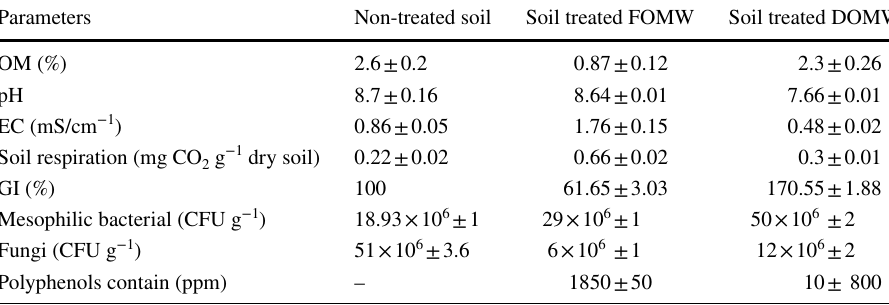
Non-treated soil was used as a control